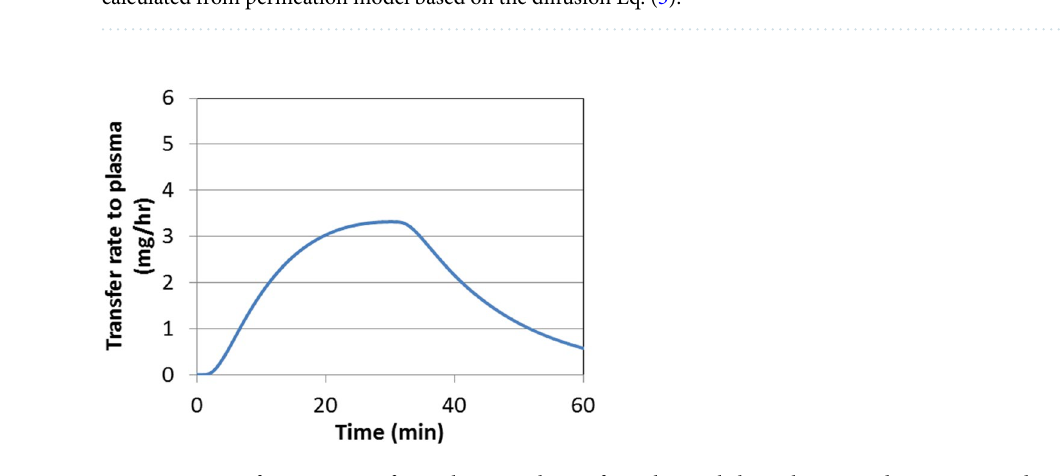
Figure 9. Rate of nicotine transfer to plasma in the BC from the smokeless tobacco product, corresponding to the release rate shown in Fig. 4, calculated from the permeation